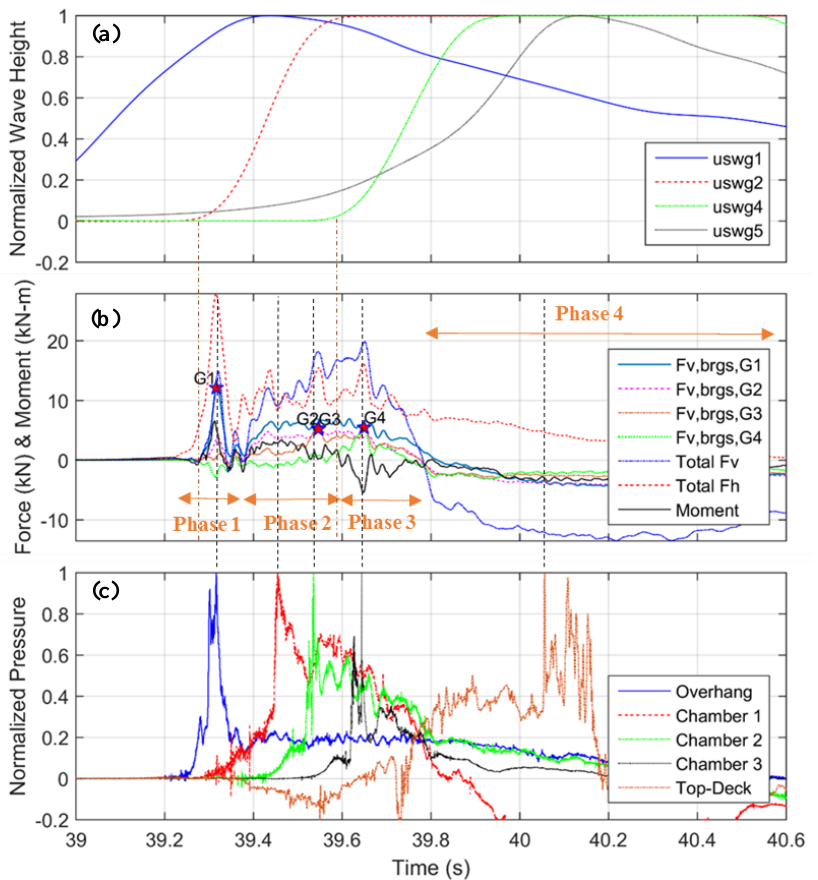
Figure 20. Tsunami-induced bearing forces and moment histories ( a ), normalized pressure histories on and below the deck (b) , and normalized wave height ( c ), for H = 1.40 m.